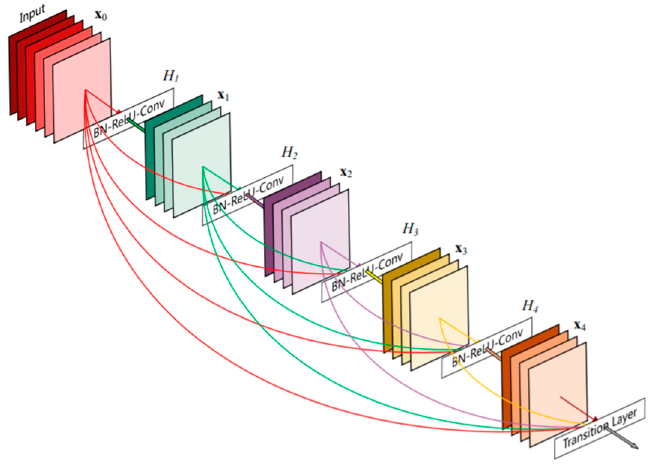
Figure 18. DenseNet block architecture [14].